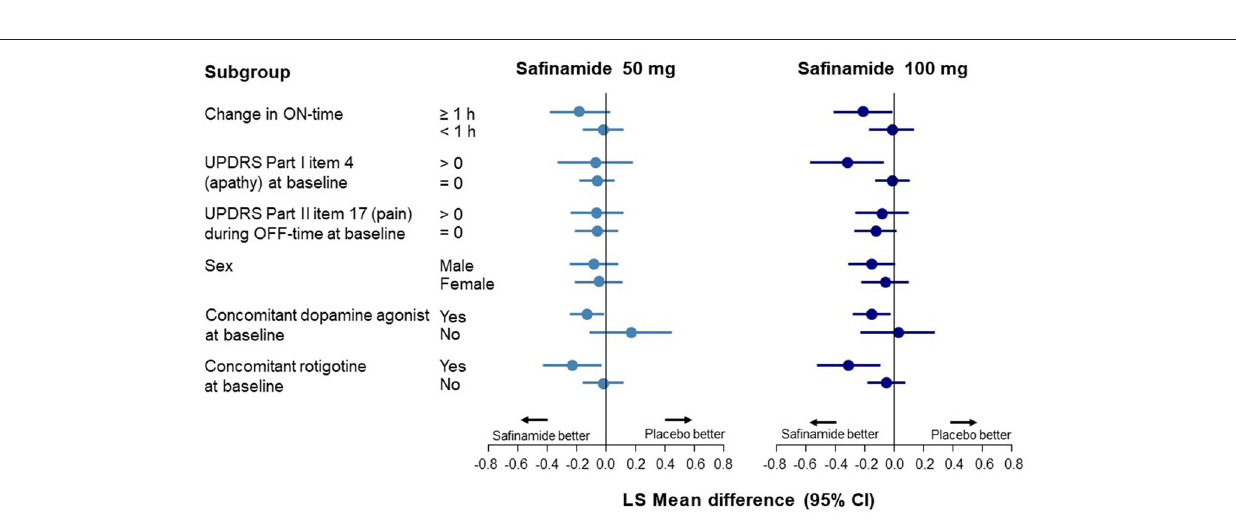
FIGURE 2 | Forest plot of change from baseline to Week 24 in the UPDRS Part I item 4 score according to subgroup. CI, confidence interval; UPDRS, Unified Parkinson’s Disease Rating